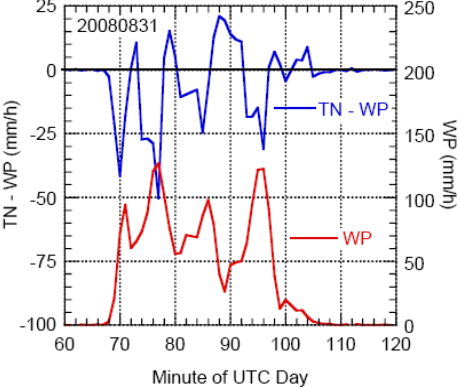
Fig. 11 One-minute rain rate differences TN-WP and rain rate from WP for the event in Fig. 9.